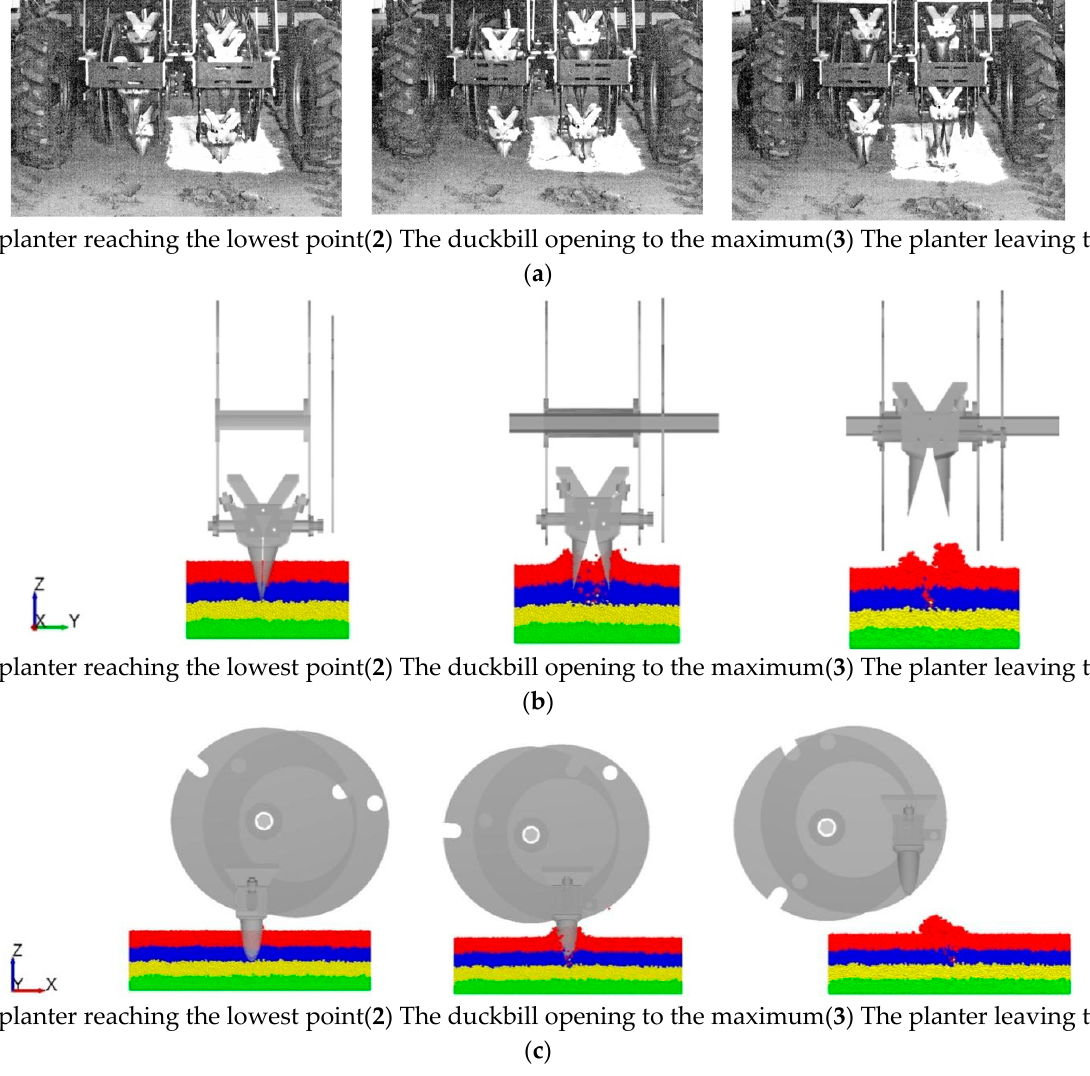
Figure 8. Analysis of soil disturbance at the contact interface. ( a ) Horizontal disturbance process of soil under high-speed photography; ( b ) horizontal disturbance during the simulation process; and ( c ) longitudinal disturbance during the simulation process.